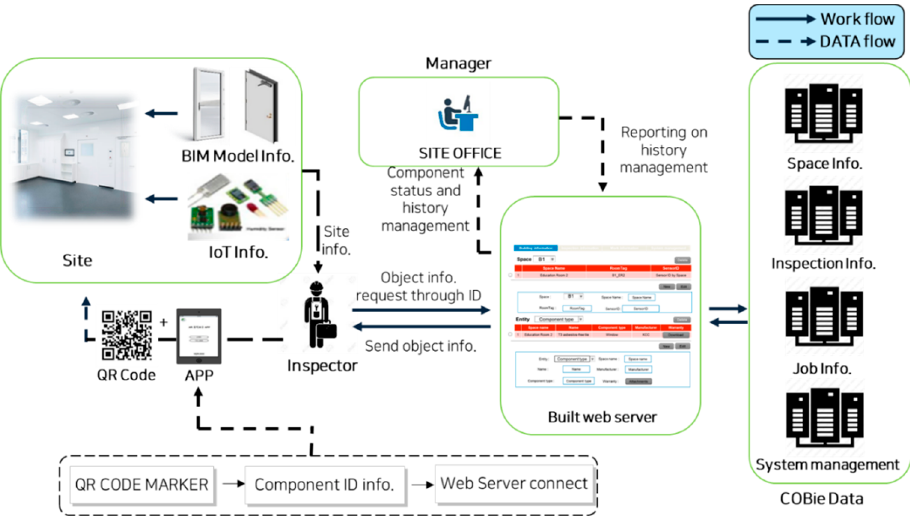
Figure 11. On-site inspection process using AR-based smart FMSs.